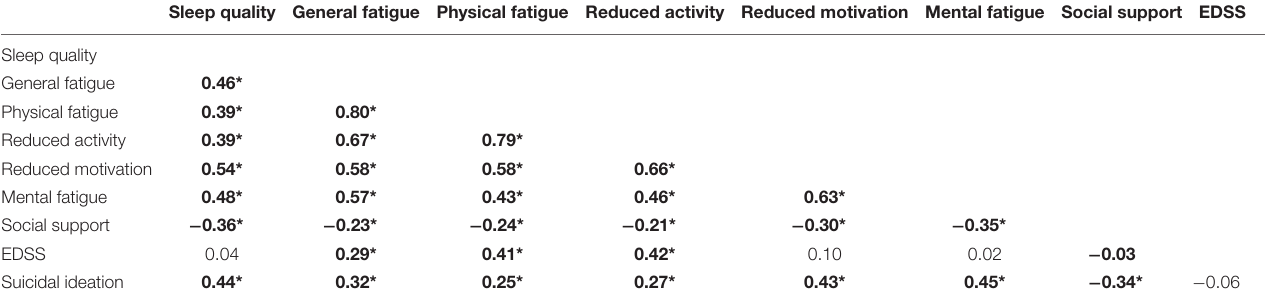
TABLE 2 | Correlations between sleep quality, types of fatigue, social support, EDSS, and